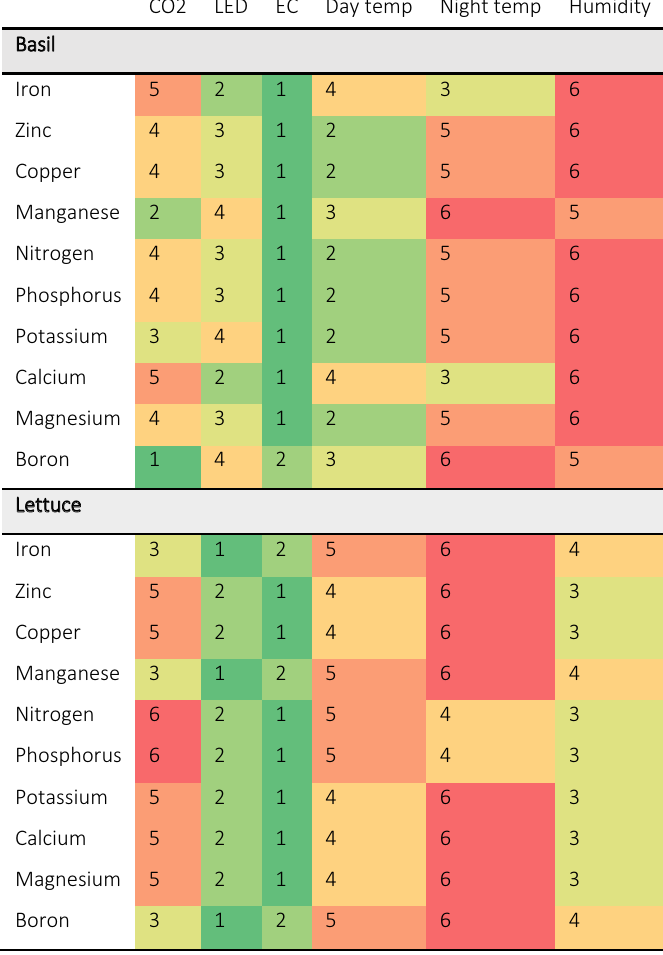
Table 7. Ranking the effect of environmental factors on micro and macro elements of basil and lettuce plants based on S/N